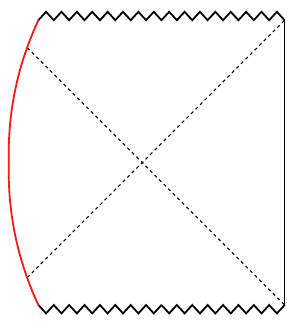
Figure 1 . Penrose diagram of an AdS black hole with the left asymptotic region terminating in an ETW brane (shown in red). The worldvolume geometry of the ETW brane is a big-bang/big-crunch cosmology.